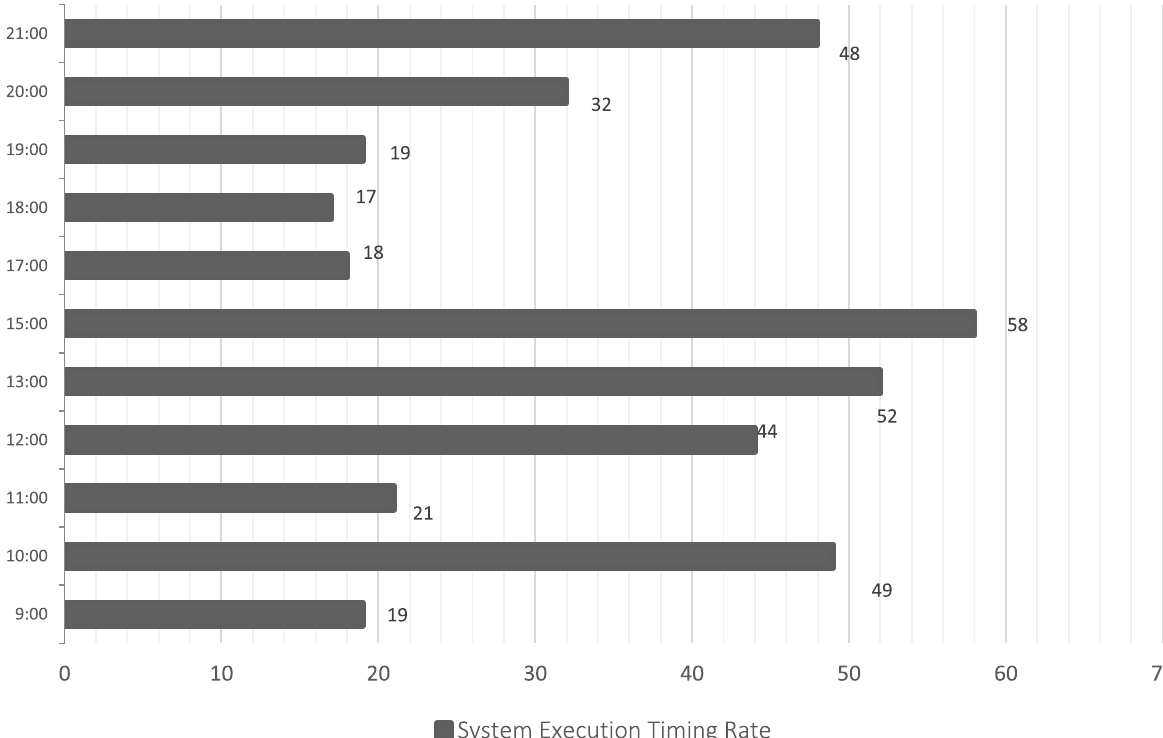
Fig. 23 The time that has been taken by the (Ad‑hoc Cloud System) to execute referred as the ‘Execution Time) in seconds throughout the